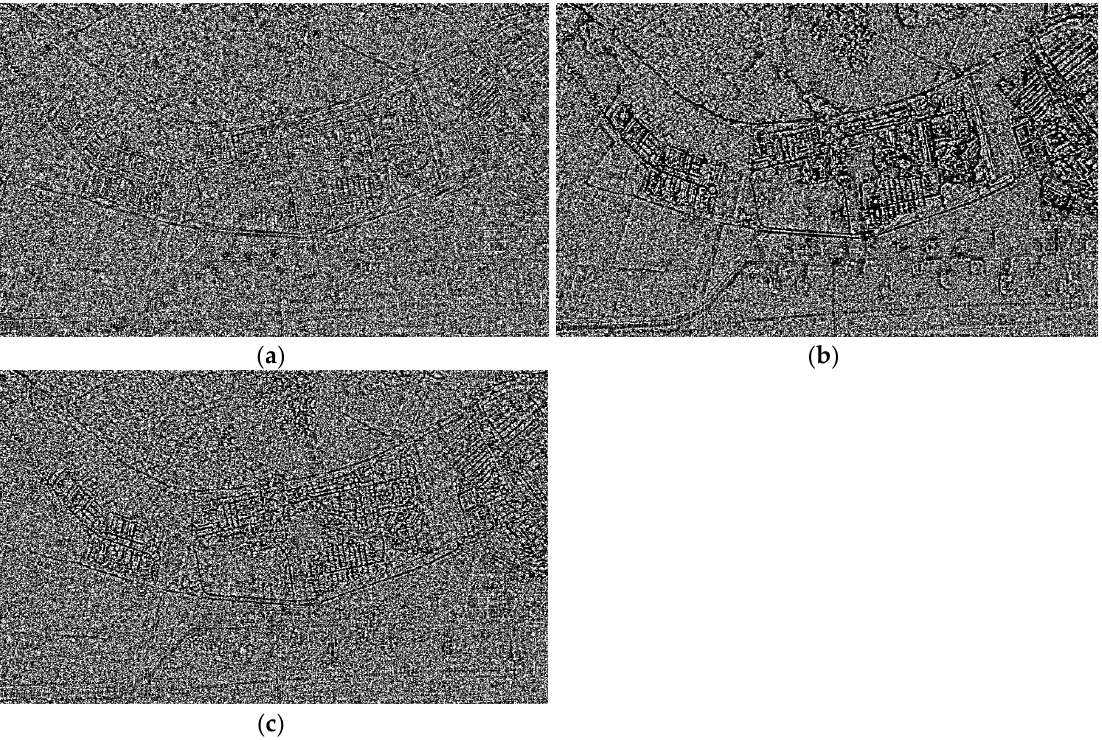
Table 3. Means and variances of the ratio images for the different superpixel segmentation algorithms with the ESAR